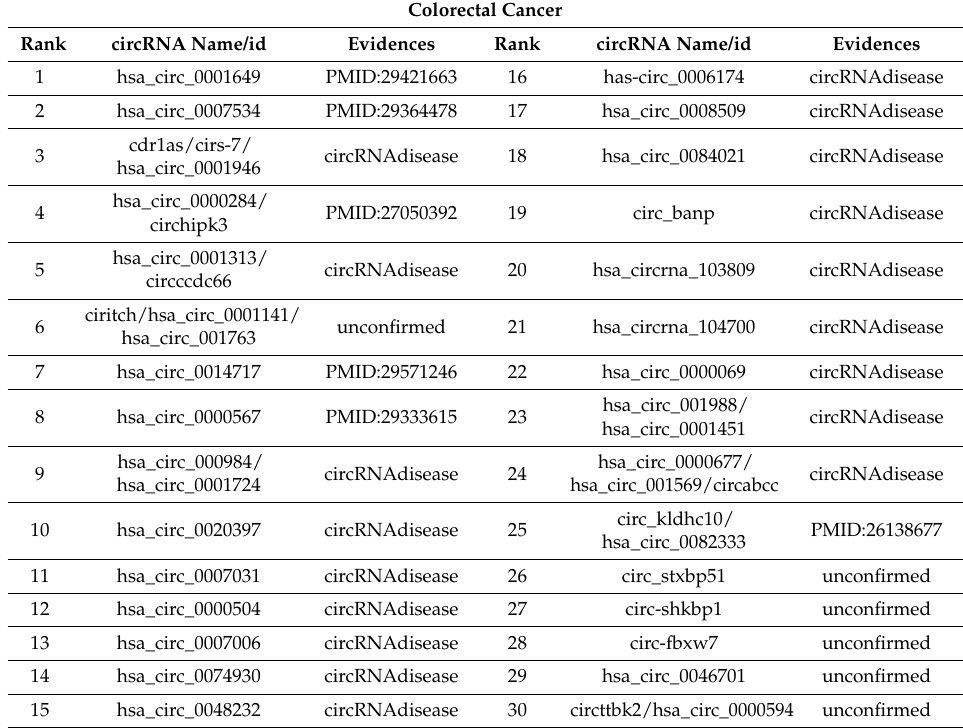
Table 5. The top 30 colorectal cancer related candidates